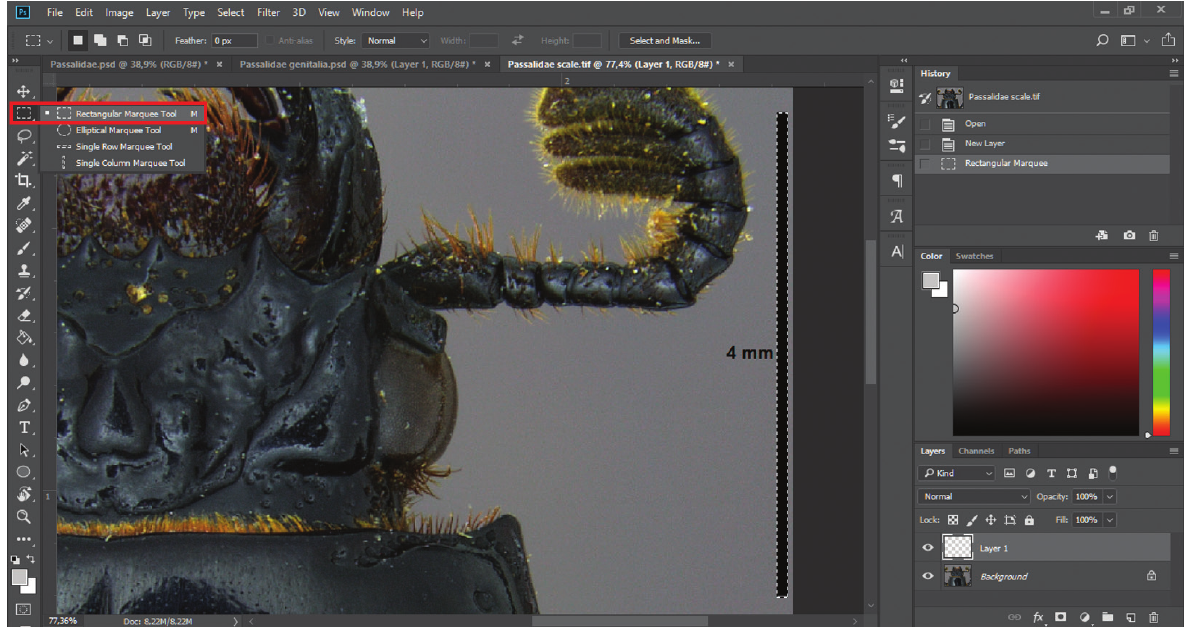
Figure 22. Method for creating a new scale using selection tools. Highlight the Closed Selection Tools group.